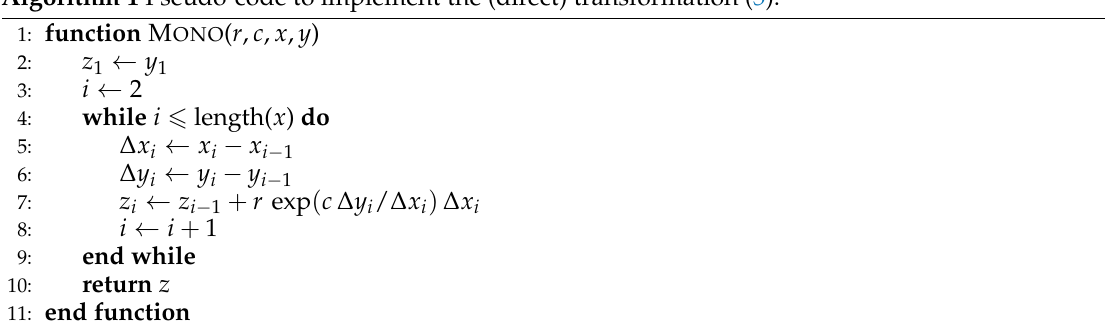
Algorithm 1 Pseudo-code to implement the (direct) transformation